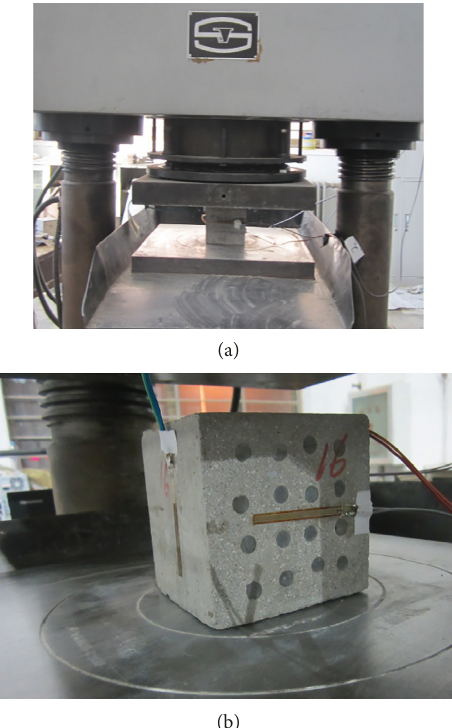
Figure 13: Pressure testing machine.